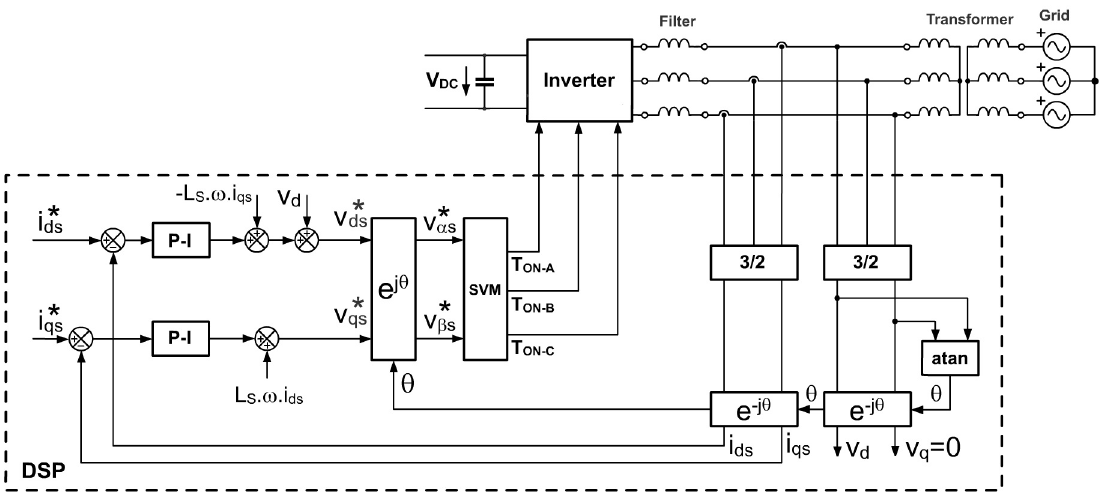
Figure 5. Diagram of the Voltage Source Inverter with grid connection.